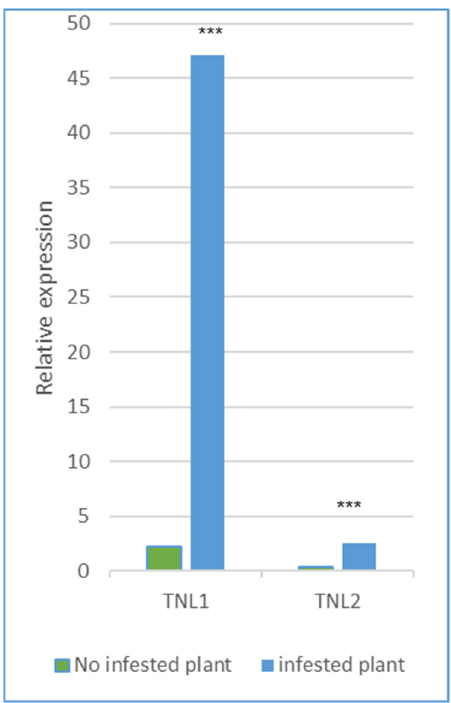
Figure 5. Expression profiling of the two genes, TNL1 and TNL2, without aphid infestation or after green peach aphid infestation in the resistant peach Weeping Flower (WFP). Data represented the mean of three replicates. *** Significative differences between no infested and infested.